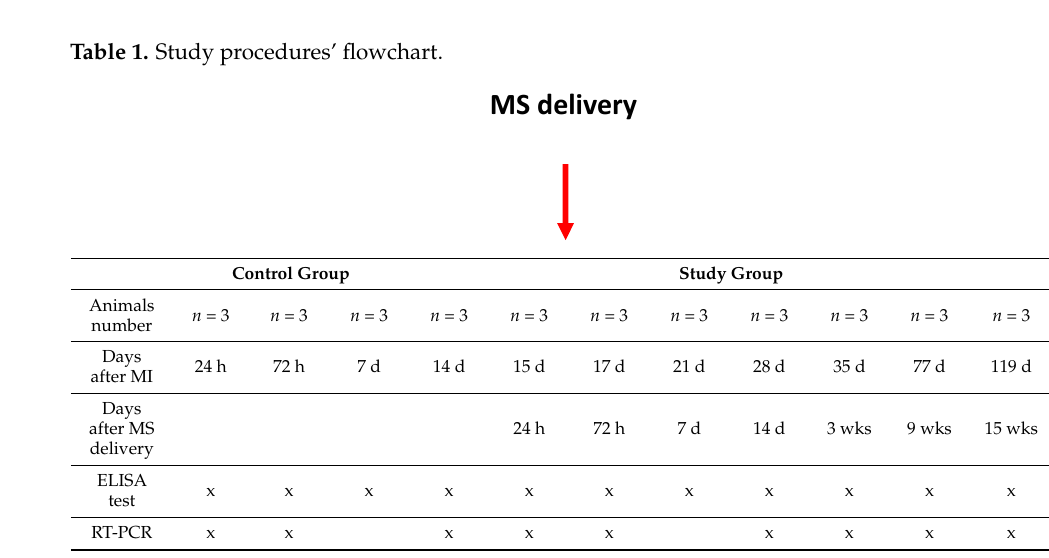
Table 1. Study procedures’ flowchart.